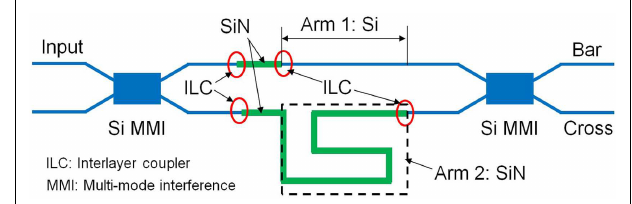
FIGURE 3 | Microscope image of fabricated Si–SiN-waveguide DL MZI